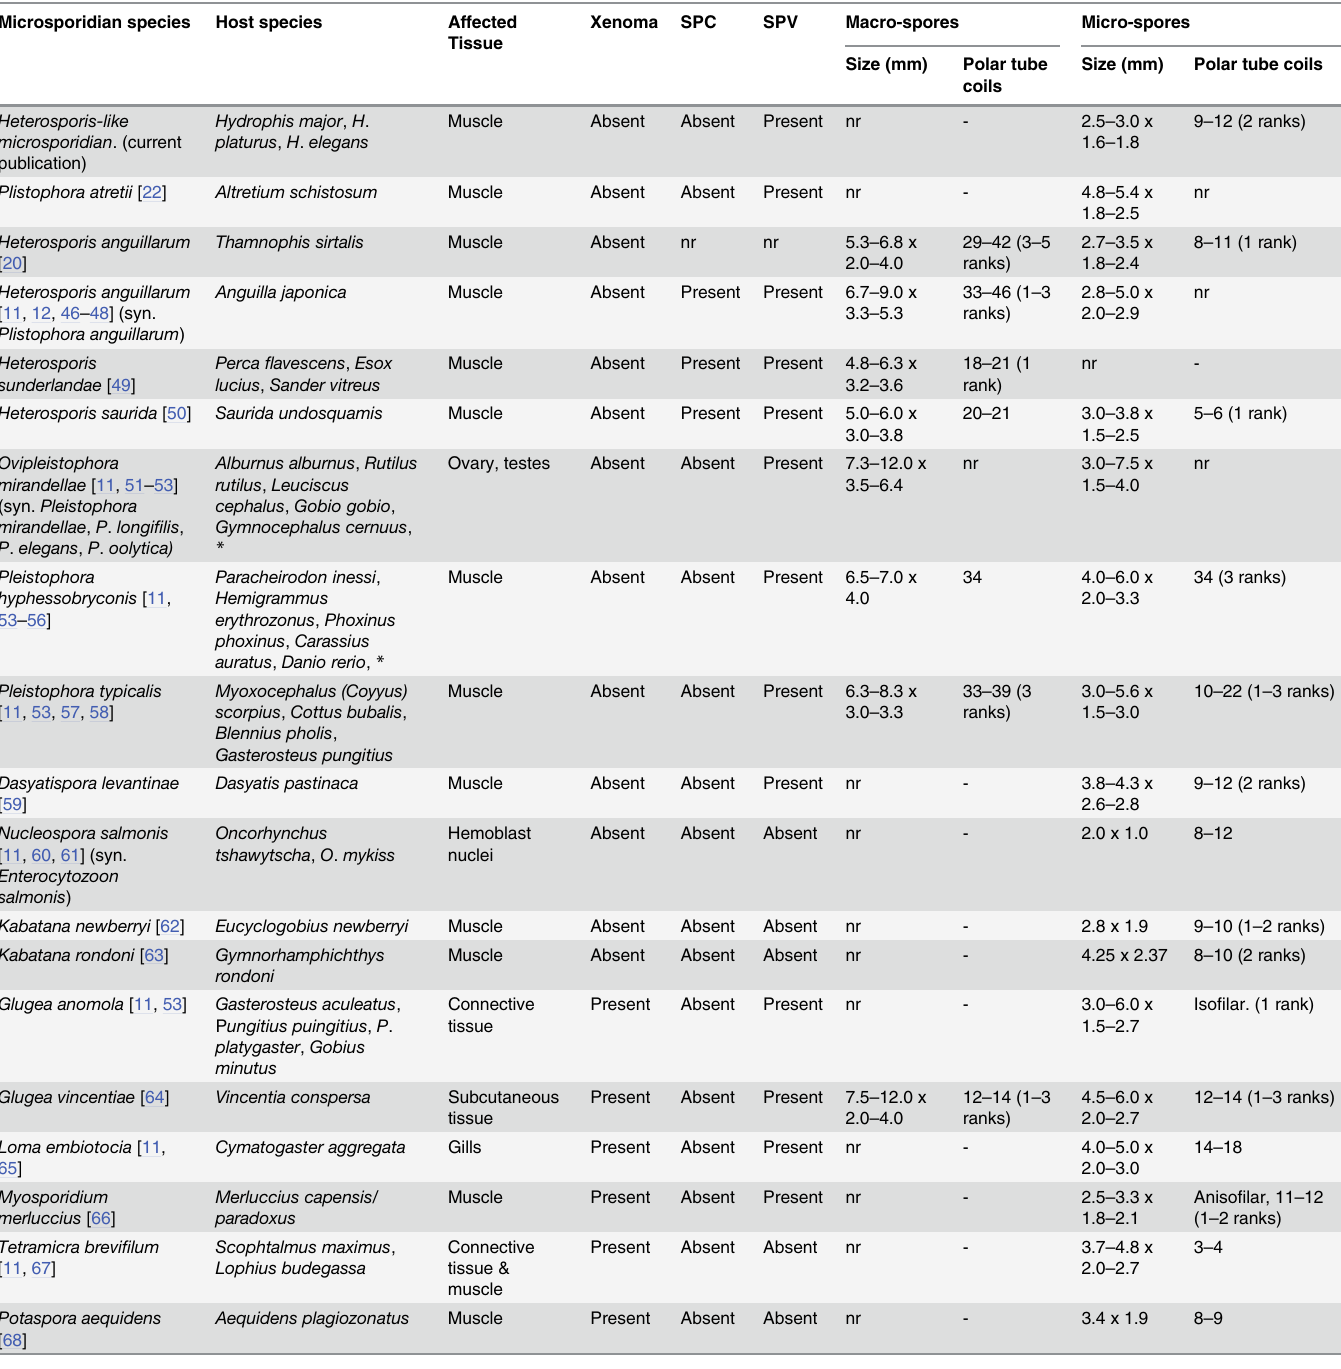
Table 2. Morphological characteristics of sea snake microsporidia compared with selected microsporidia in marine and freshwater hosts. Microsporidian species Host